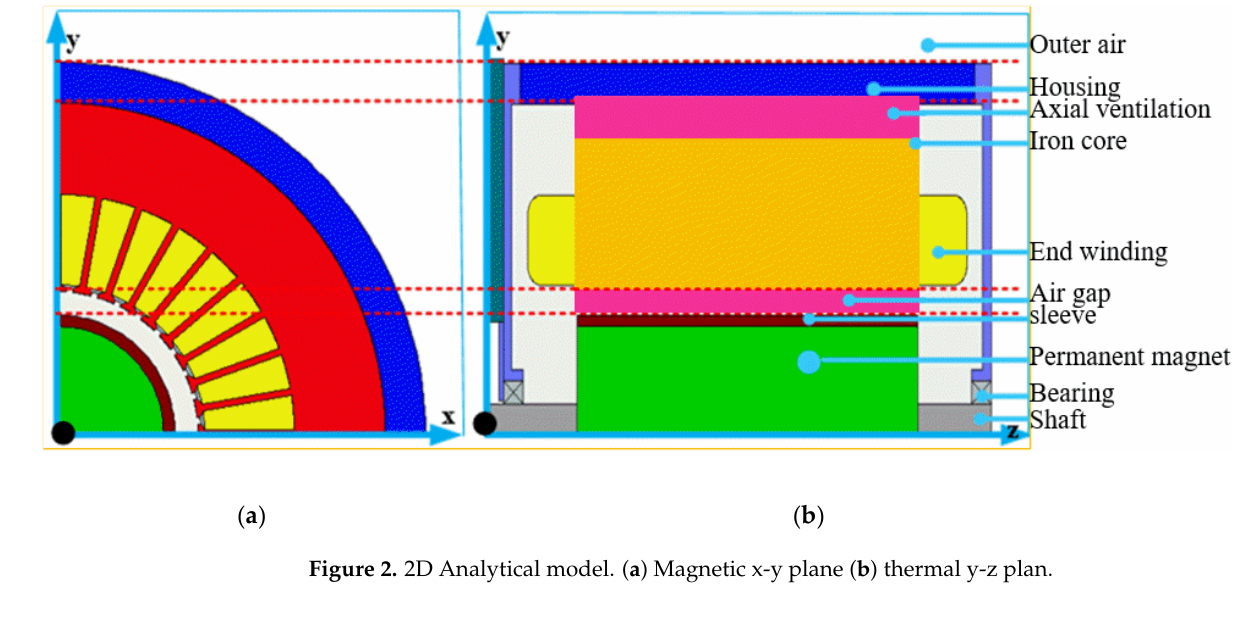
Figure 2. 2D Analytical model. ( a ) Magnetic x-y plane ( b ) thermal y-z plan. Table 2. Basic HSPMSM’s material thermal properties.